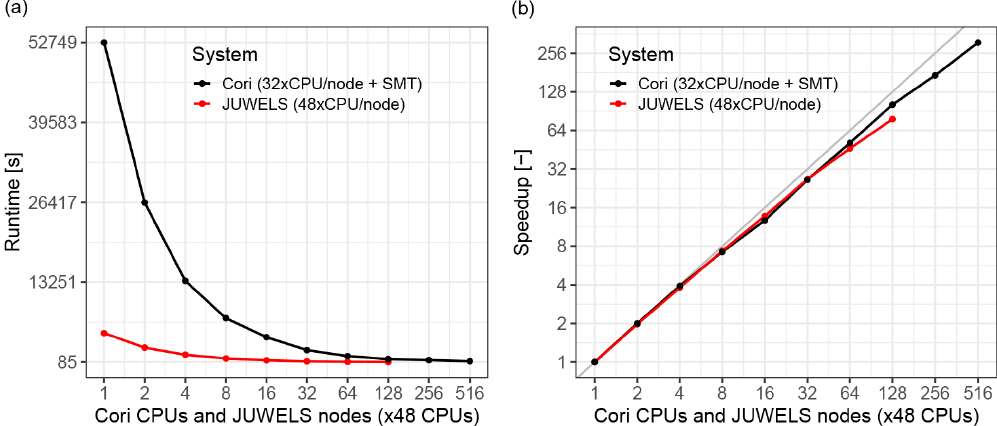
Figure 18. Runtime (a) and speed up (b) for a strong-scaling experiment with SERGHEI-SWE using CPUs on Cori and JUWELS for the short rainfall event. See Table 4 for details on the